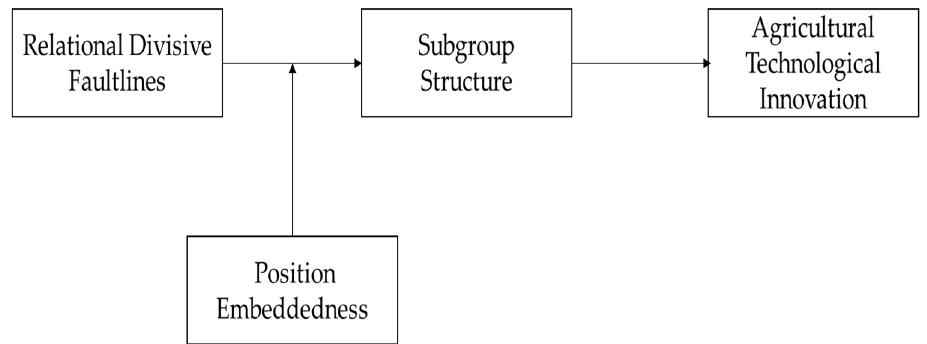
Figure 1. Conceptual Model of this